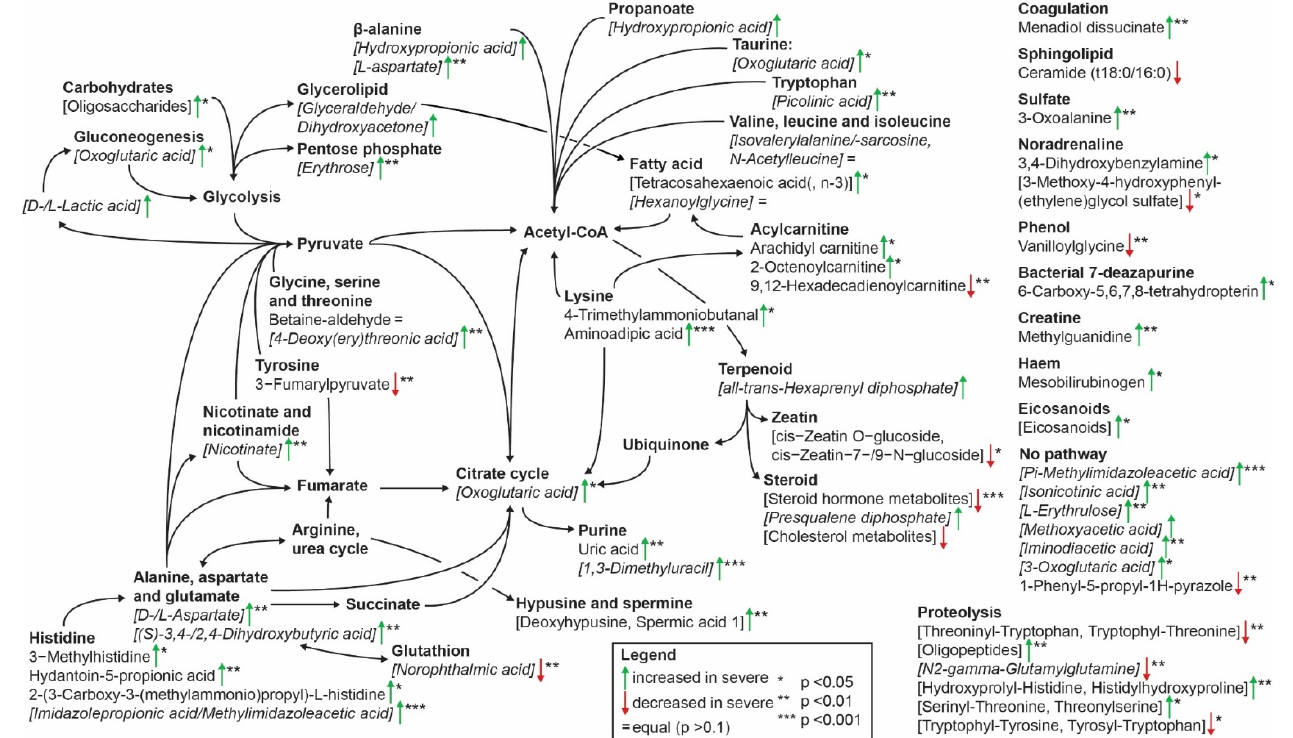
Figure 2. Pathway analysis in peaks with multiple annotated metabolites. Pathways identified for the top 25 metabolites in each of the biomarker identification models. Square brackets indicate metabolites annotated to peaks including other metabolites; italics indicate that ≥ 1 annotated metabolite was connected to ≥ 1 different pathway. Arrows indicate metabolites increased (green upward arrow) or decreased (red downward arrow) in subjects with severe phenotypes compared with subjects with no or mild phenotypes. Asterisks denote the level of significance in Mann–Whitney U tests (* p < 0.05, ** p < 0.01, *** p < 0.001). Metabolites that did not associate with disease severity ( p > 0.1) are indicated with an equals sign (“=”). Lists of annotated metabolites were condensed as in Figure